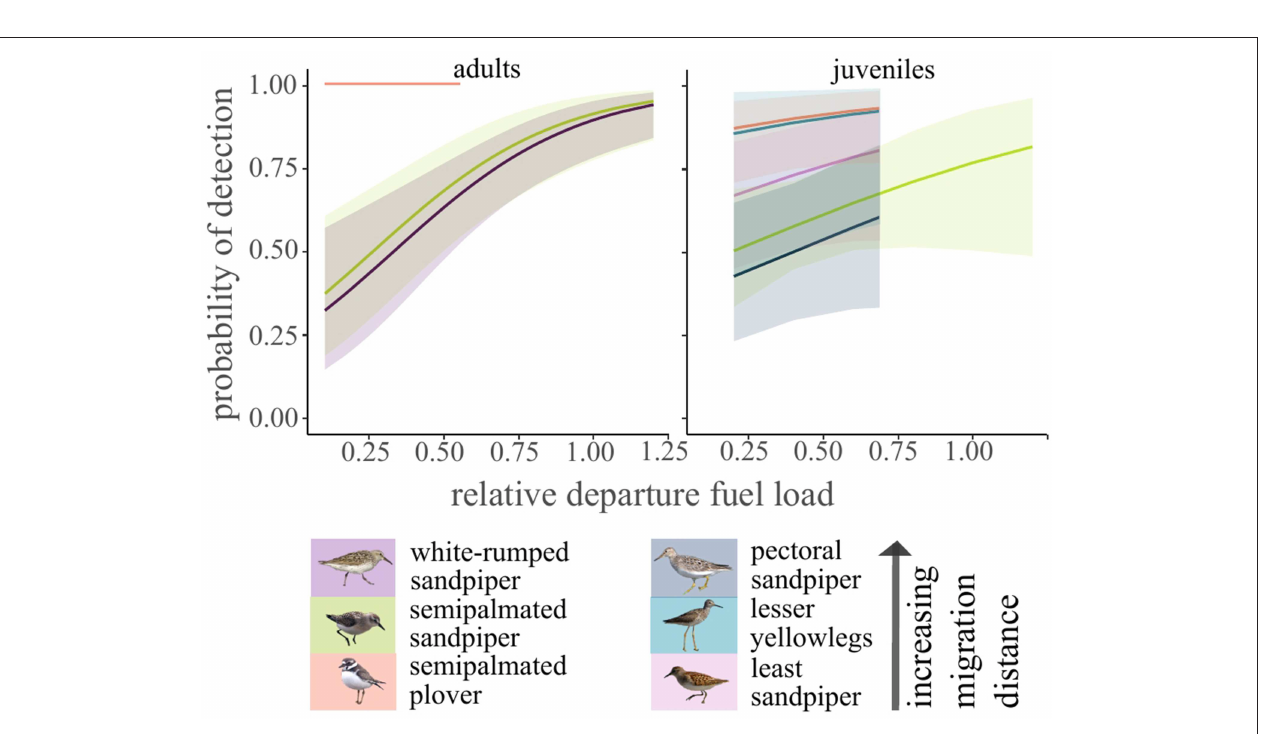
Frontiers in Ecology and Evolution |